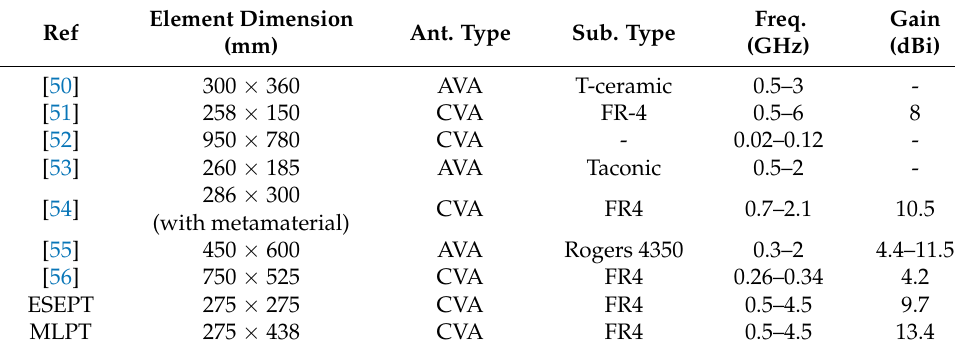
Table 2. Comparison of the proposed antenna and related research.